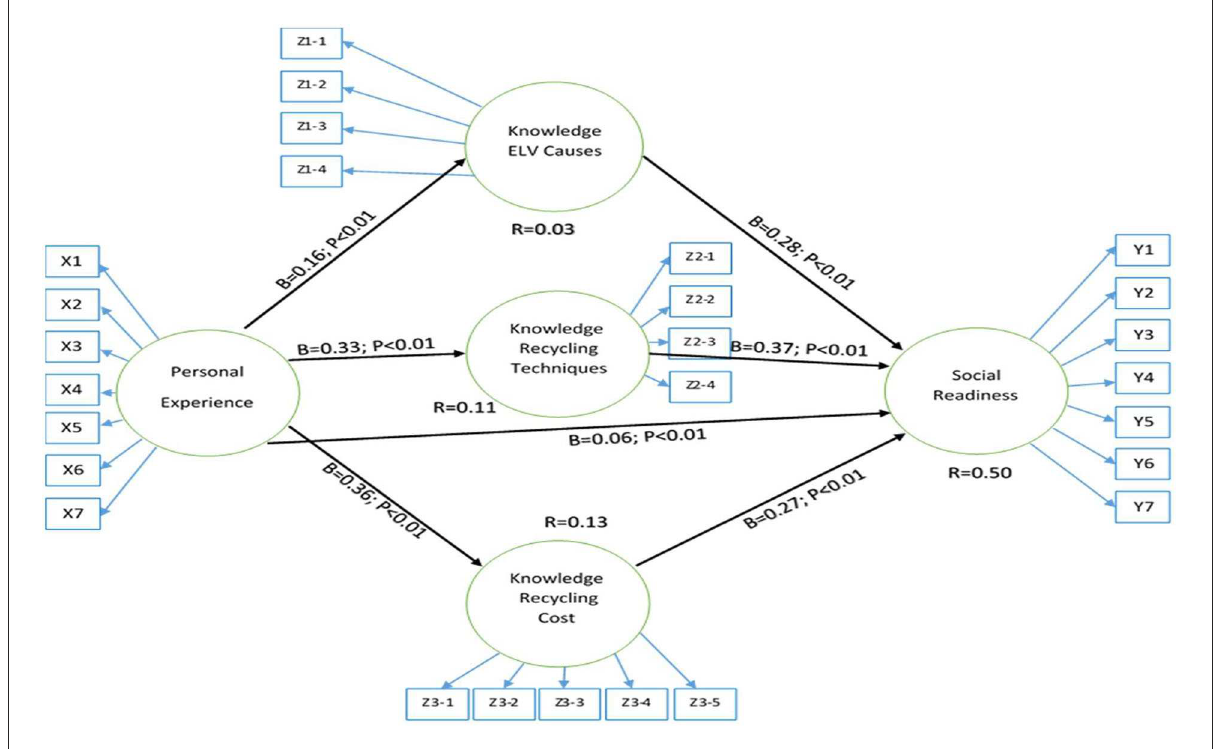
FIGURE3 The final path model with standardized regression coefficients.